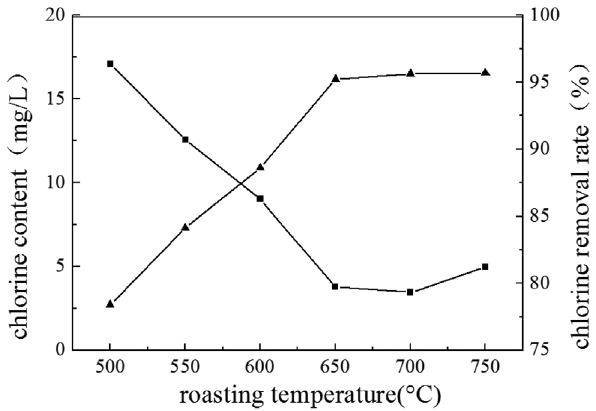
Fig. 5: Effect of roasting temperature on chlorine content and Cl removal rate